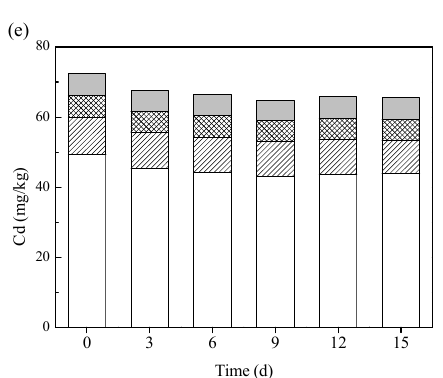
Figure A2. Variation in partitioning of chemical forms of Zn ( a ), Cu ( b ), Pb ( c ), Cr ( d ), and Cd ( e ) during bioleaching without sulfur.